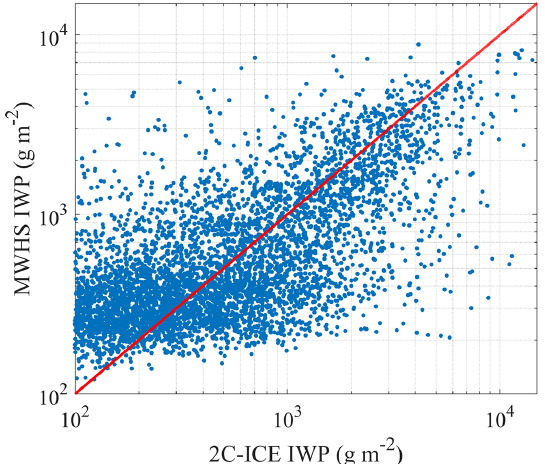
Figure 10. Comparison between 2C-ICE and MWHS IWP. The red line represents the diagonal 1 : 1 line. Clear-sky scenes are not shown.